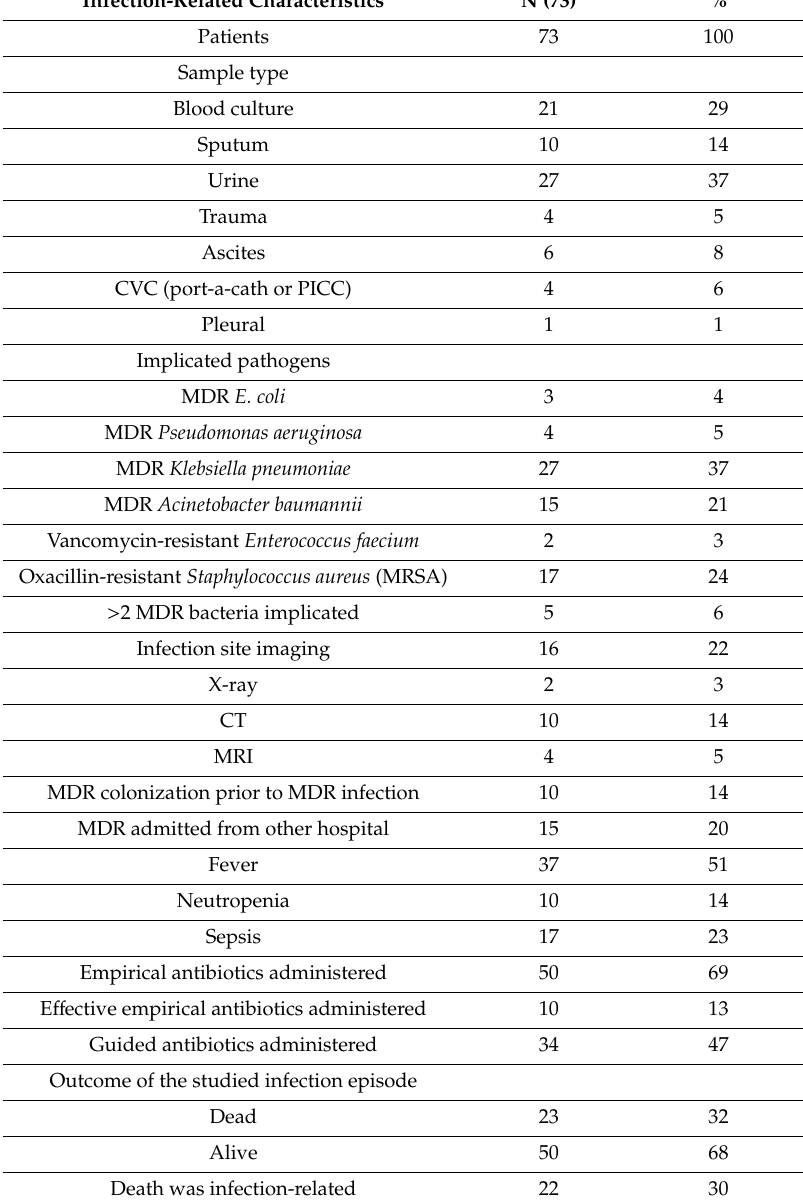
Table 2. Infection-related